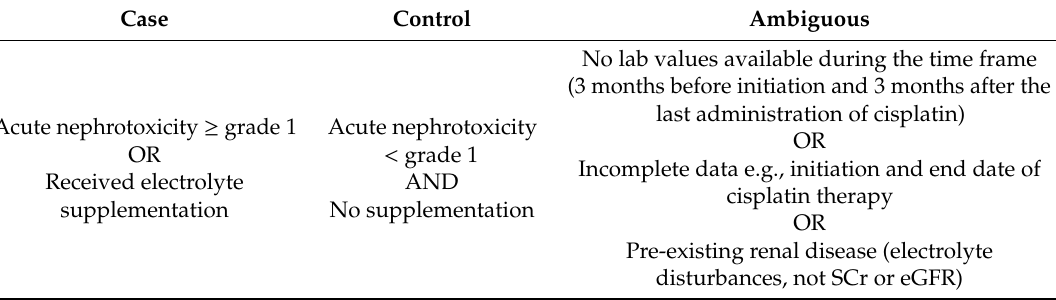
Table 2. Case-control designation according to Adjusted-AKI outcome